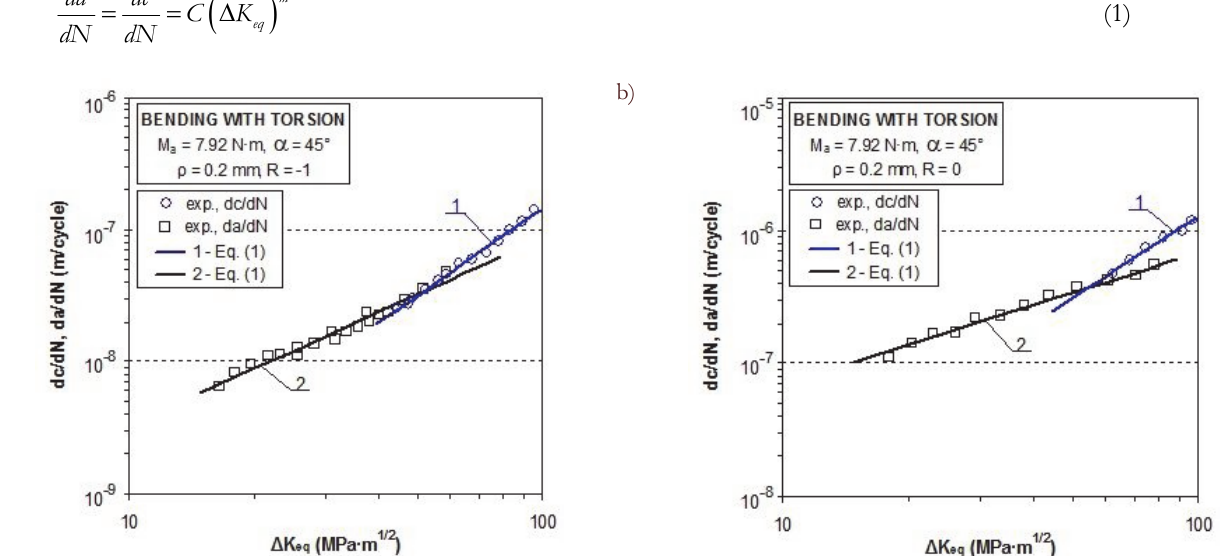
Figure 7: Comparison of the test results with calculations according to Eq. (1) for specimens under bending with torsion: a) R = -1, b) R =